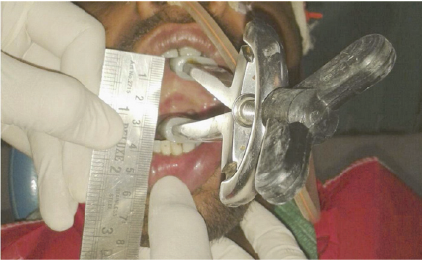
Figure 7: 7th postoperative day assisted mouth opening—33 mm.